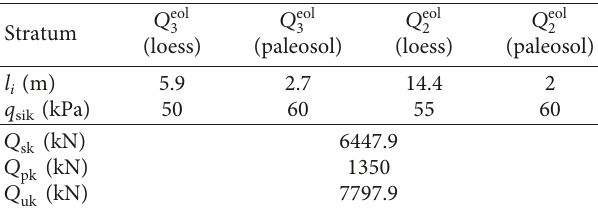
Table 3: Estimation of bearing capacity for the test piles. Stratum